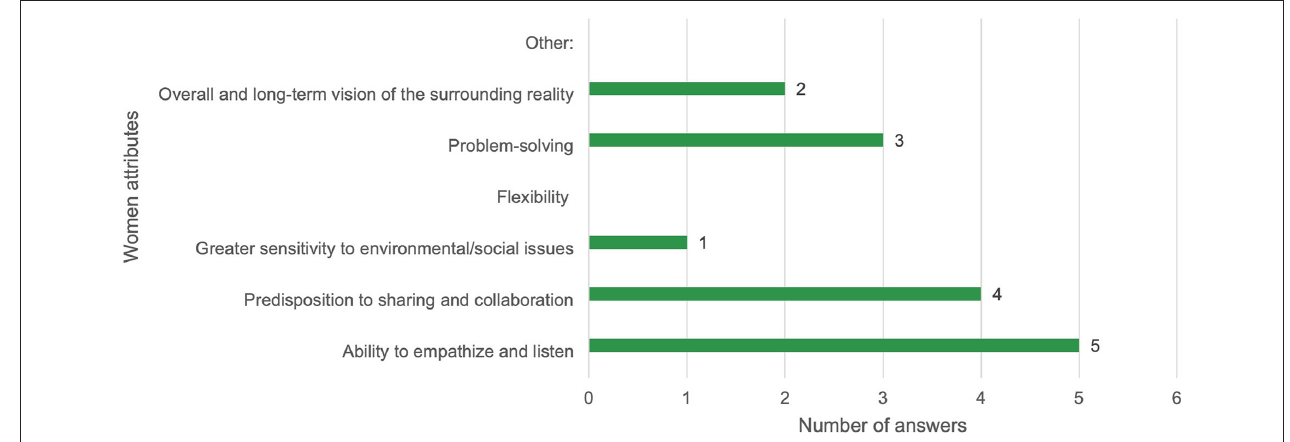
FIGURE 9 | Sustainability female leader